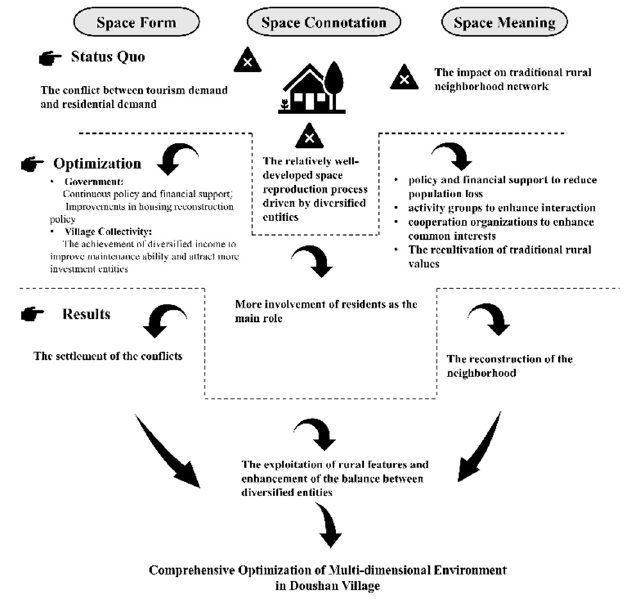
Figure 13. The optimization path of multi-dimensional environment in Doushan Village.